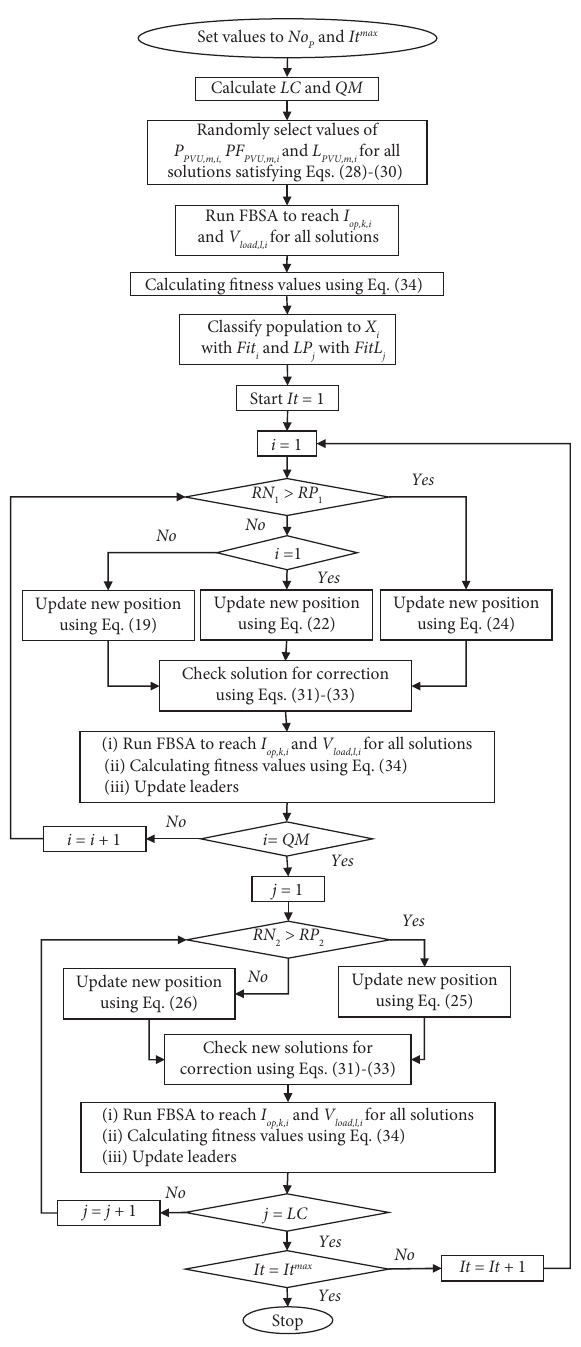
Figure 2: Flowchart of applying COOA for the studied